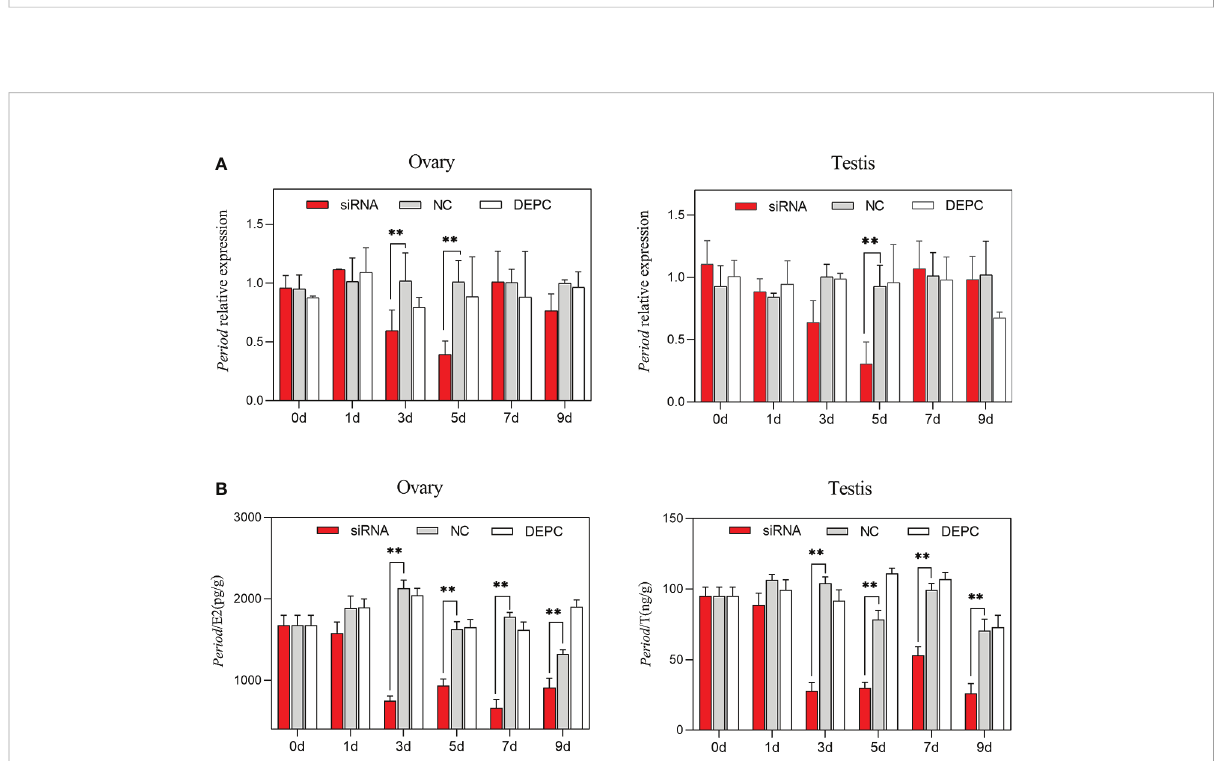
FIGURE 7 Gene expression of Period and sex hormone secretion after siRNA interference. (A) Relative expression of Period in the ovary and testis among groups after siRNA interference (n=6). (B) The sex hormone contents changes among groups after siRNA interference (E2, estradiol; T, testosterone; n=6). Asterisks indicate signi fi cant differences: ** P <